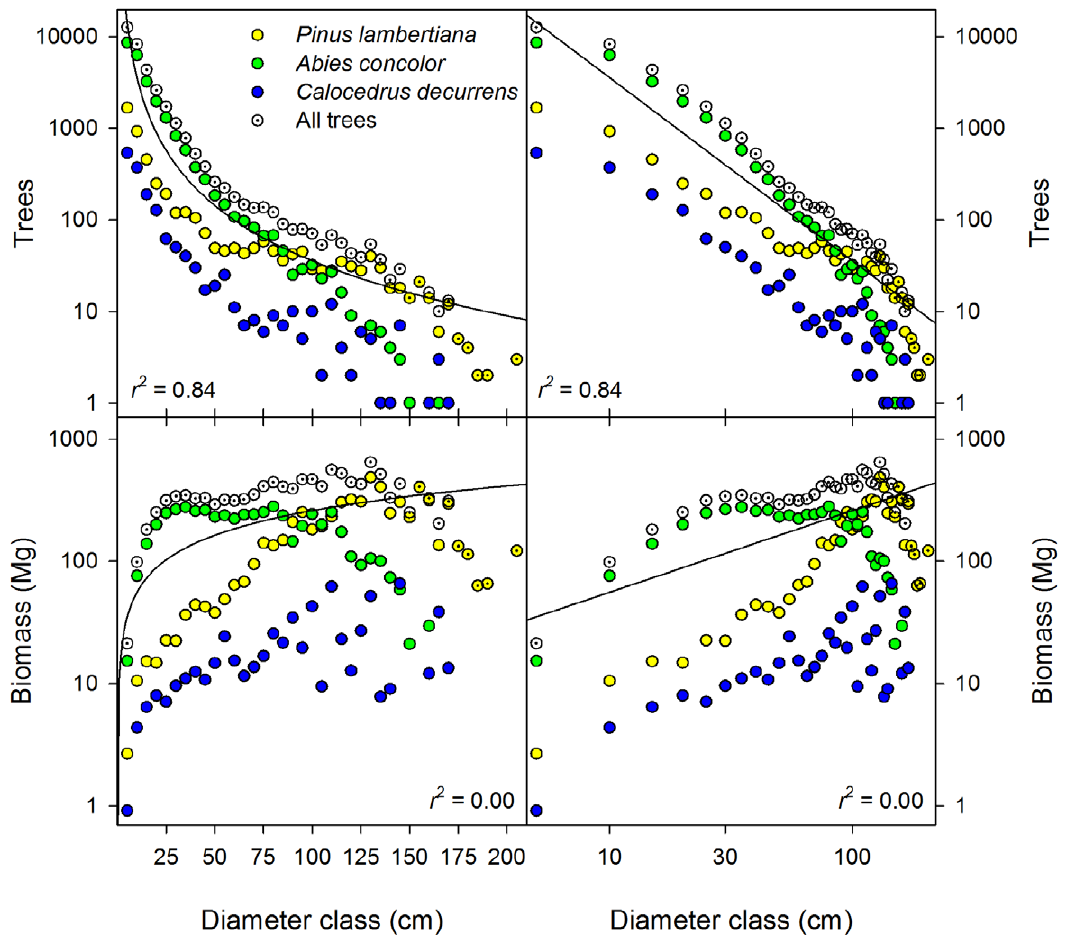
Figure 2. Diameter distribution of the number of trees and the biomass of trees in the Yosemite Forest Dynamics Plot. Each point represents a 5 cm diameter class (first bin; 1 cm # dbh , 5 cm) of the trees from the entire 25.6 ha plot (34,458 live stems $ 1 cm dbh totaling 12,897 Mg); identical data are shown with linear diameter bins (left) and log diameter (right). Solid lines represent the best fitting equation of the form specified by scaling theory, tree density ~ Ar { 2 (r 2 =0.84) and biomass ~ Br 2 = 3 (r 2 =0.00), where r is tree radius.